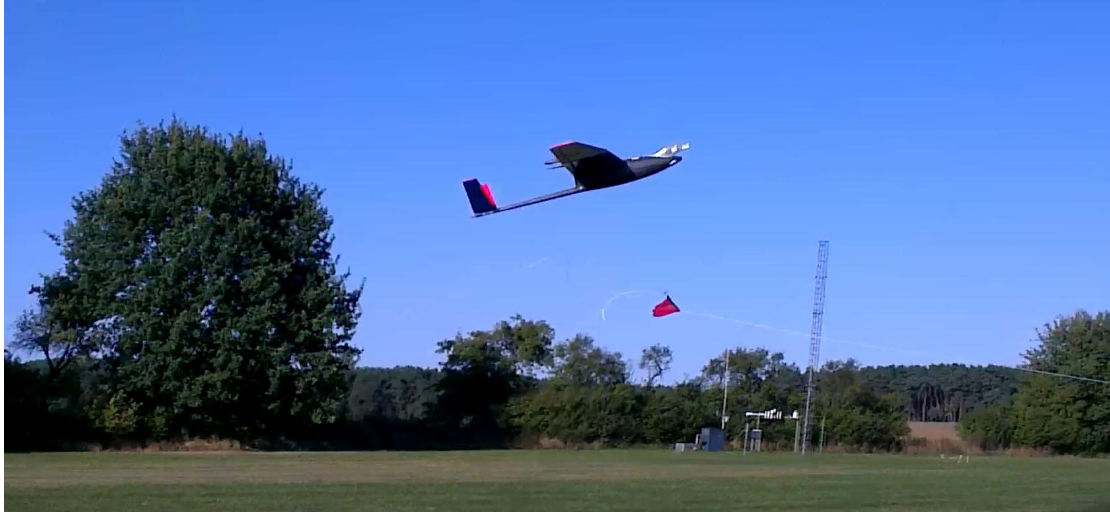
Figure 1. Research unmanned aerial vehicle (UAV) Multi-purpose Airborne Sensor Carrier (MASC) during take-off with a